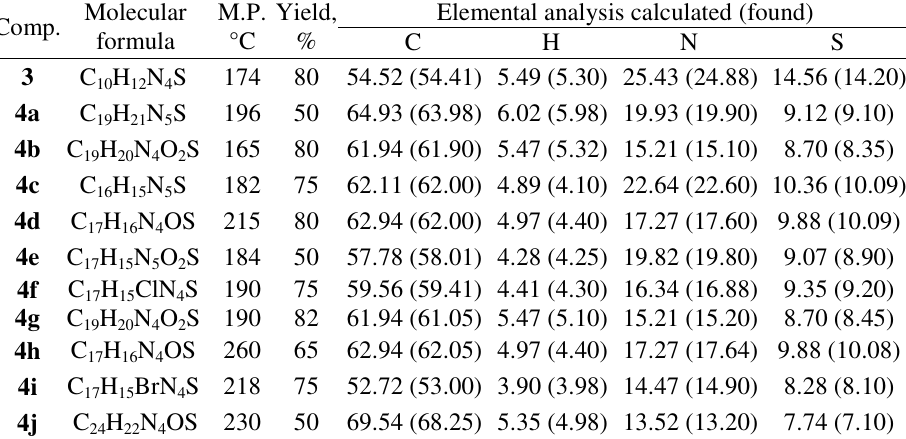
Table 1. Physical and analytical data of compounds ( 3 , 4a-j) Elemental analysis calculated (found) Comp.